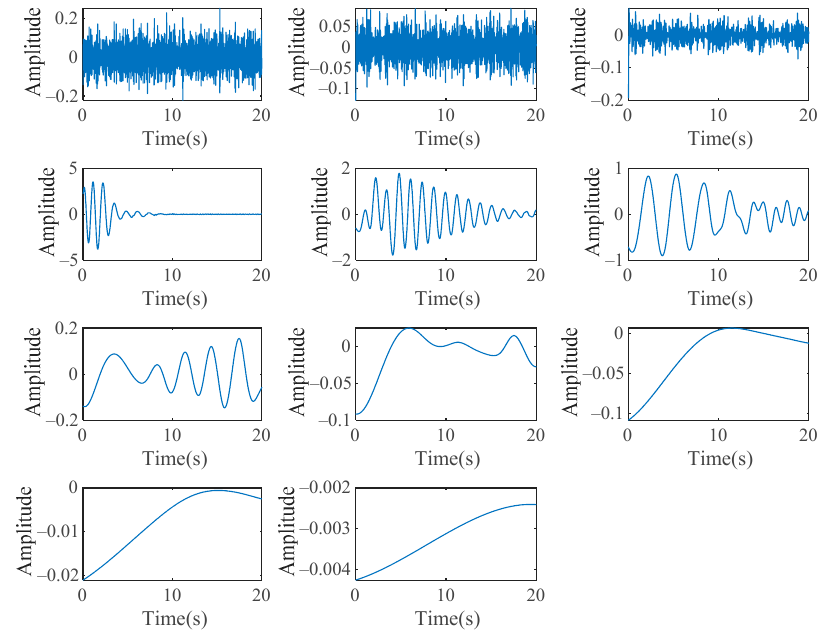
Figure 4. All IMFs of signal A obtained by EMD.